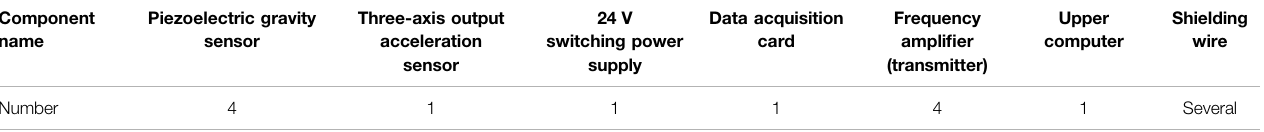
TABLE 1 | Hardware of the monitoring system. Component